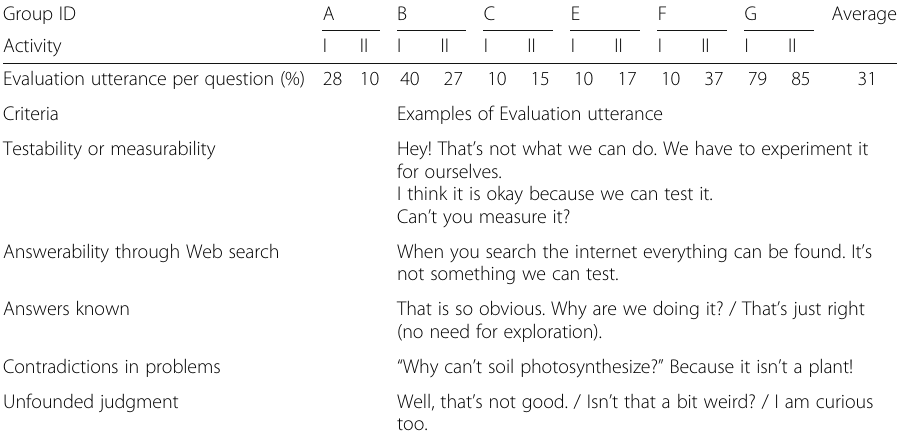
Table 4 Evaluation utterances Group ID A B C E F G Activity